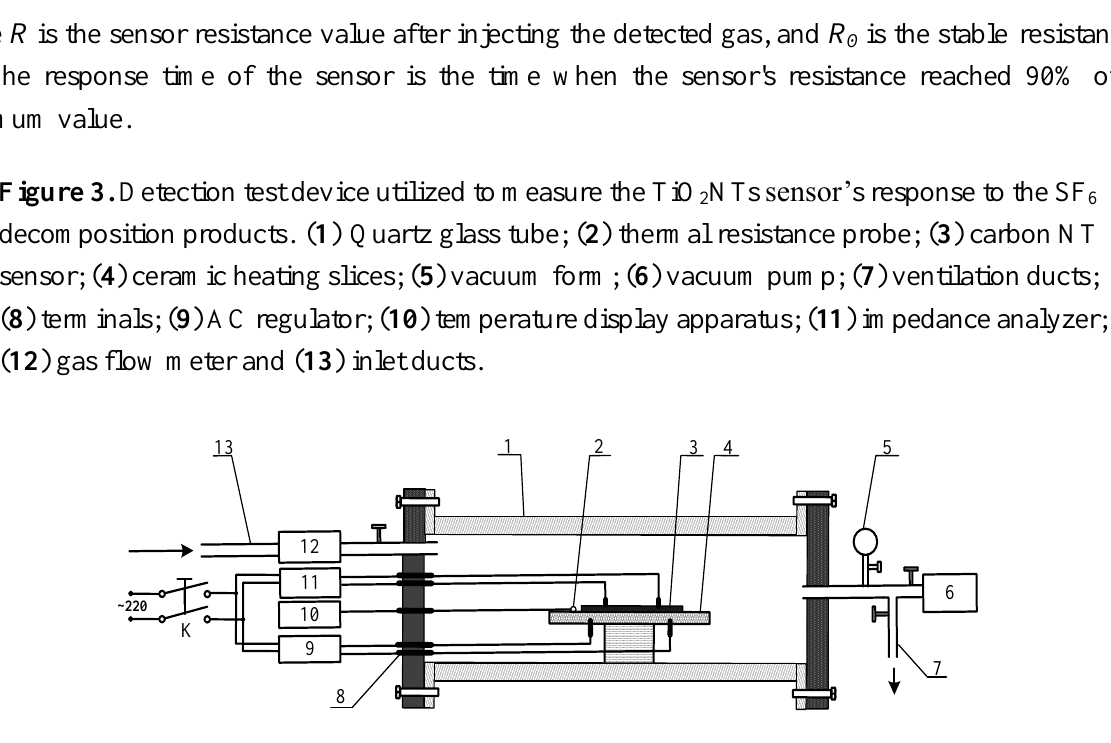
Figure 3. Detection test device utilized to measure the TiO